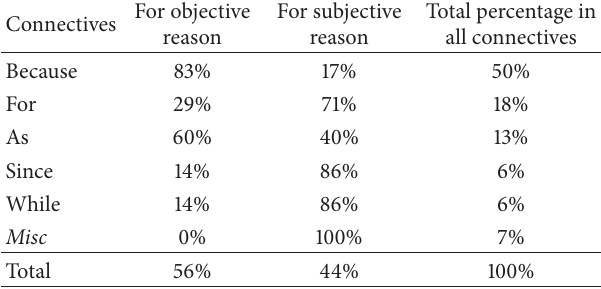
Figure 1: Possible routes of category learning between causes and effects.